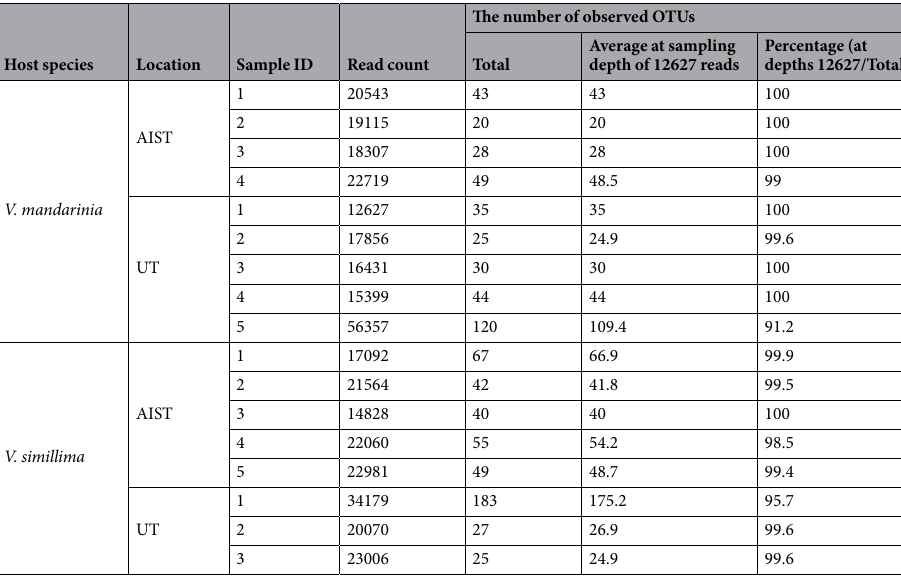
Table 1. Sequence reads used in this study and rarefaction analysis of the number of OTUs. Host species, locations of sampling, read counts and rarefaction analysis in terms of the number of observed OTUs are shown. The OTU numbers at sampling depth of 12627 reads are average of ten iterations. AIST, the National Institute of Advanced Industrial Science and Technology; UT, the University of